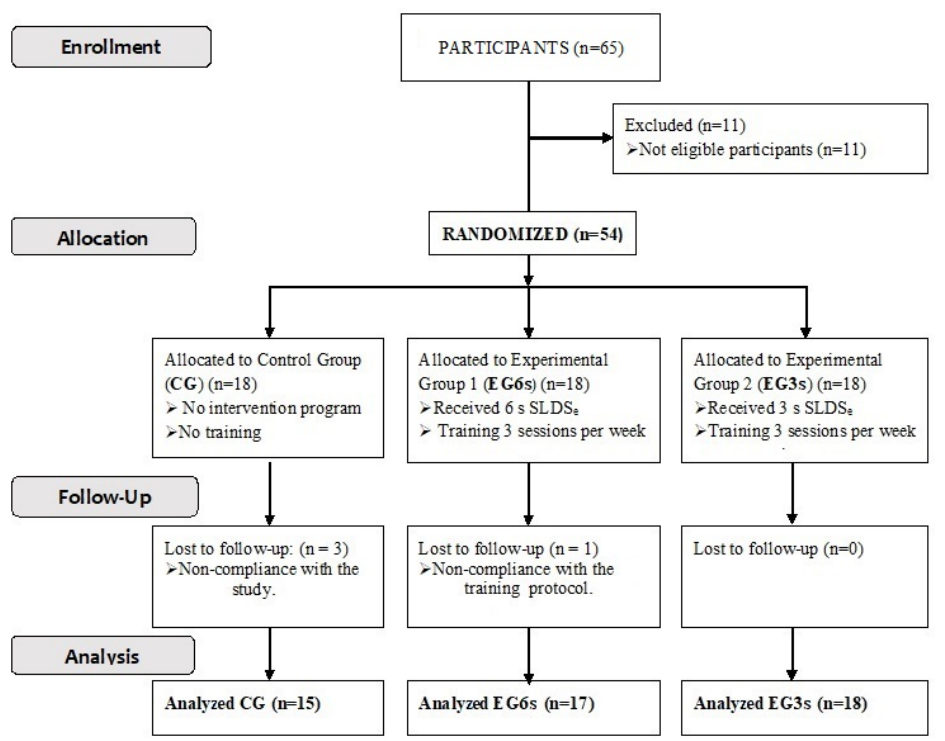
Figure 1. Participants and inclusion procedure.